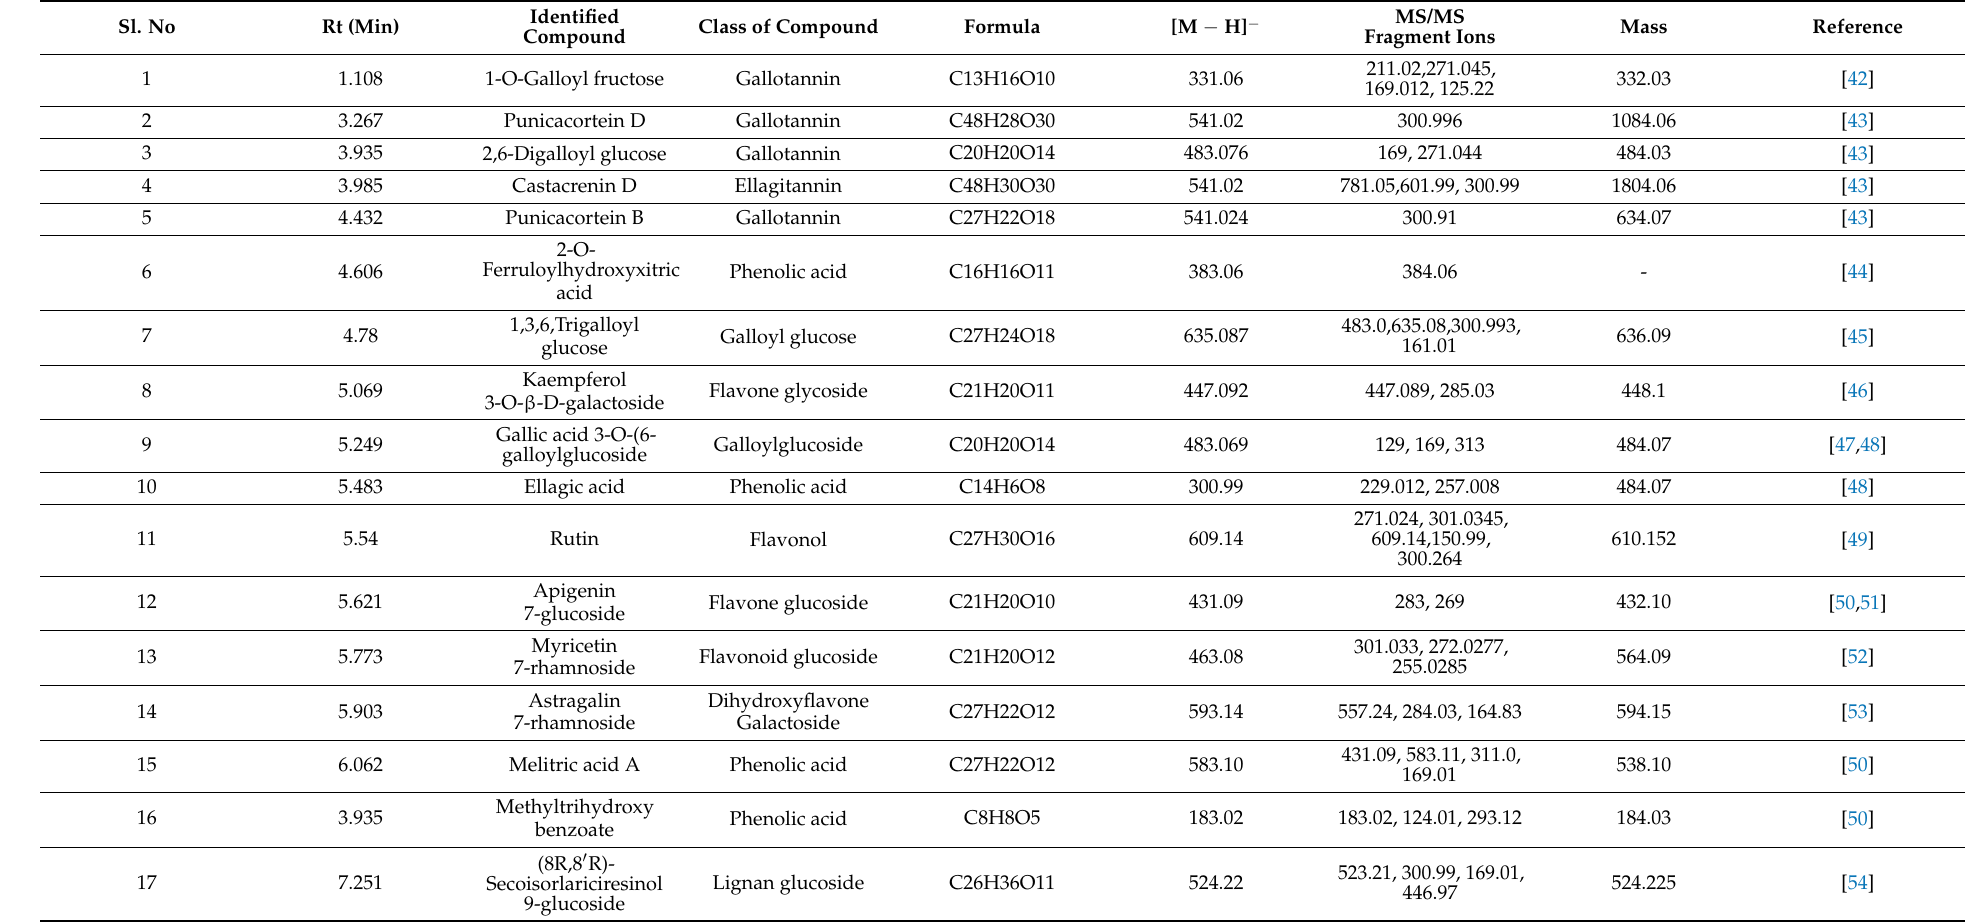
Table 4. Ultrahigh-performance liquid chromatography and MS/MS analysis in negative mode of TCAF2 isolated from the leaf acetone extract of Terminalia catappa